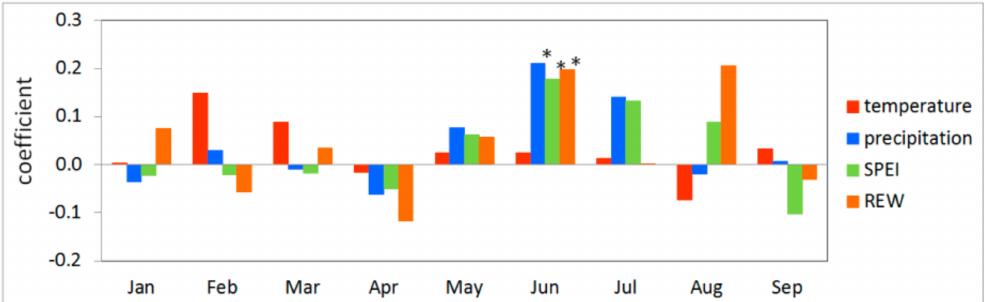
Figure 8. Coefficients of response-function analysis (PCA) among indices and standard chronologies, stars indicate 95% significance level (SPEI: standardized precipitation evapotranspiration index, REW: relative extractable